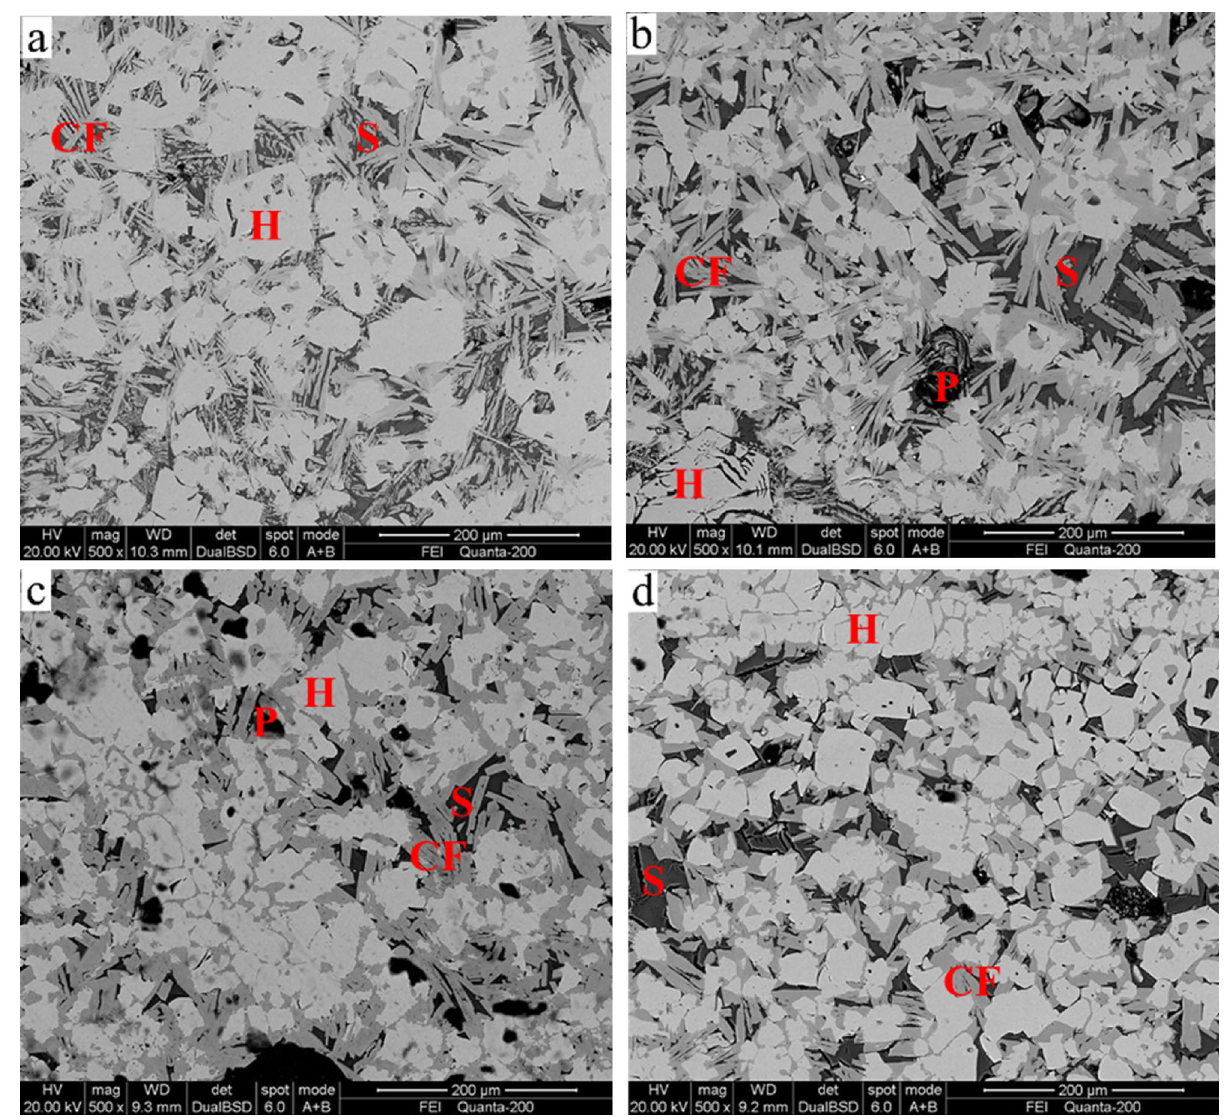
Figure 10. SEM images of the microstructure of the sinter for 40% anthracite substitution for coke breeze. H, Hematite (white); CF, calcium ferrite (grey); S, complex silicate (black); P,